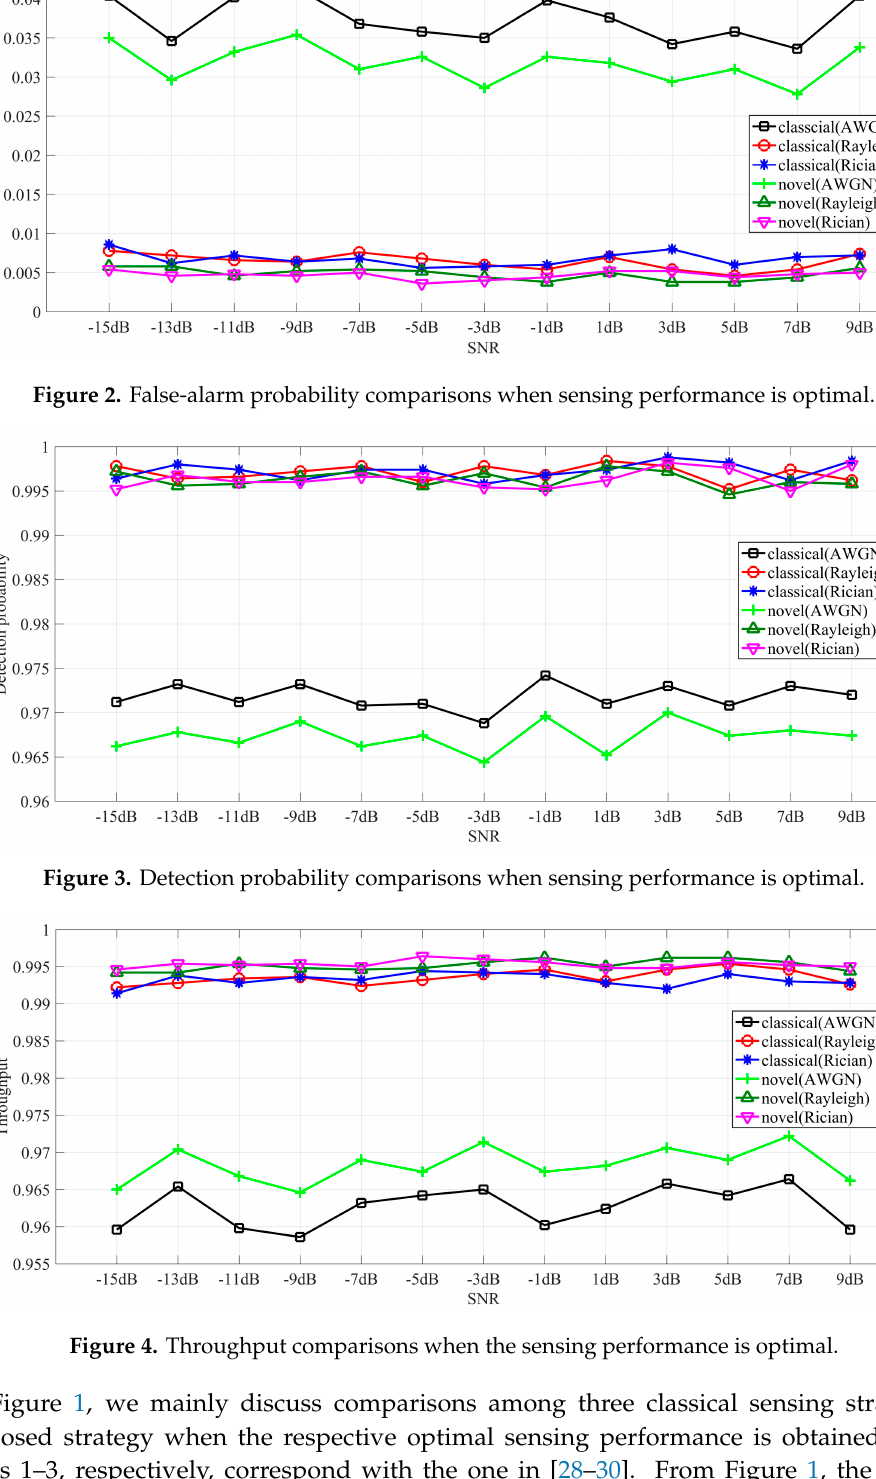
Figure 4. Throughput comparisons when the sensing performance is optimal.